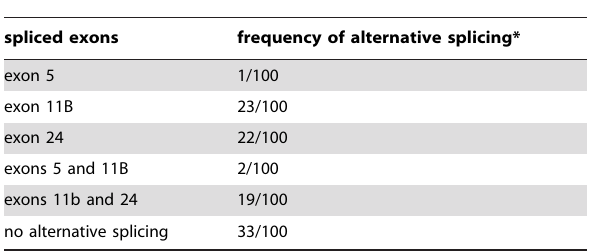
Table 1. Frequency of spliced exons in MelJuSo cells.